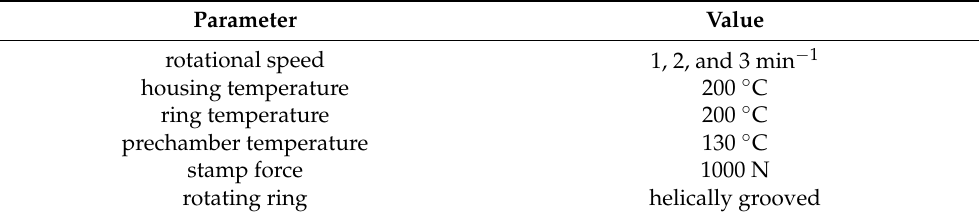
Table 1. Overview of the testing parameters